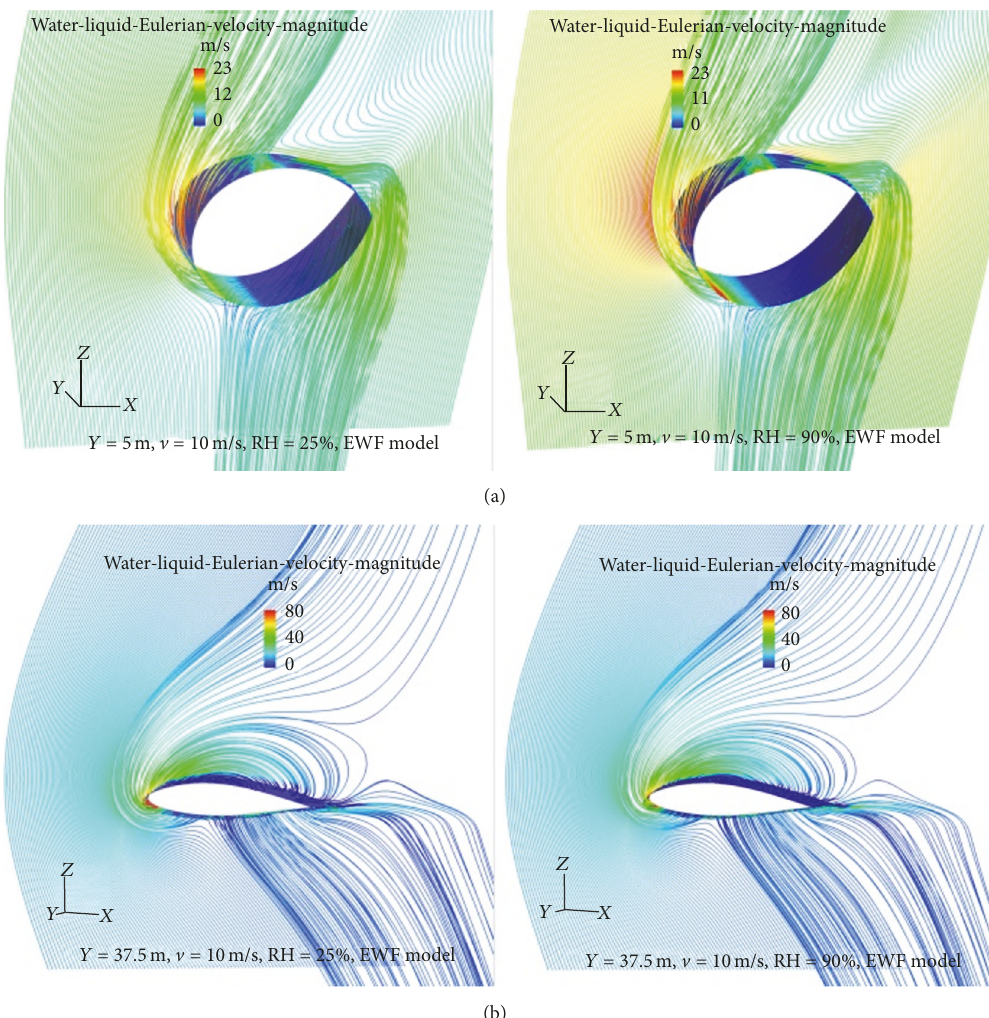
Figure 18: Streamline of velocity at blade clip location for (a) 𝑌 = 3.5 m and (b) 𝑌 = 37.5